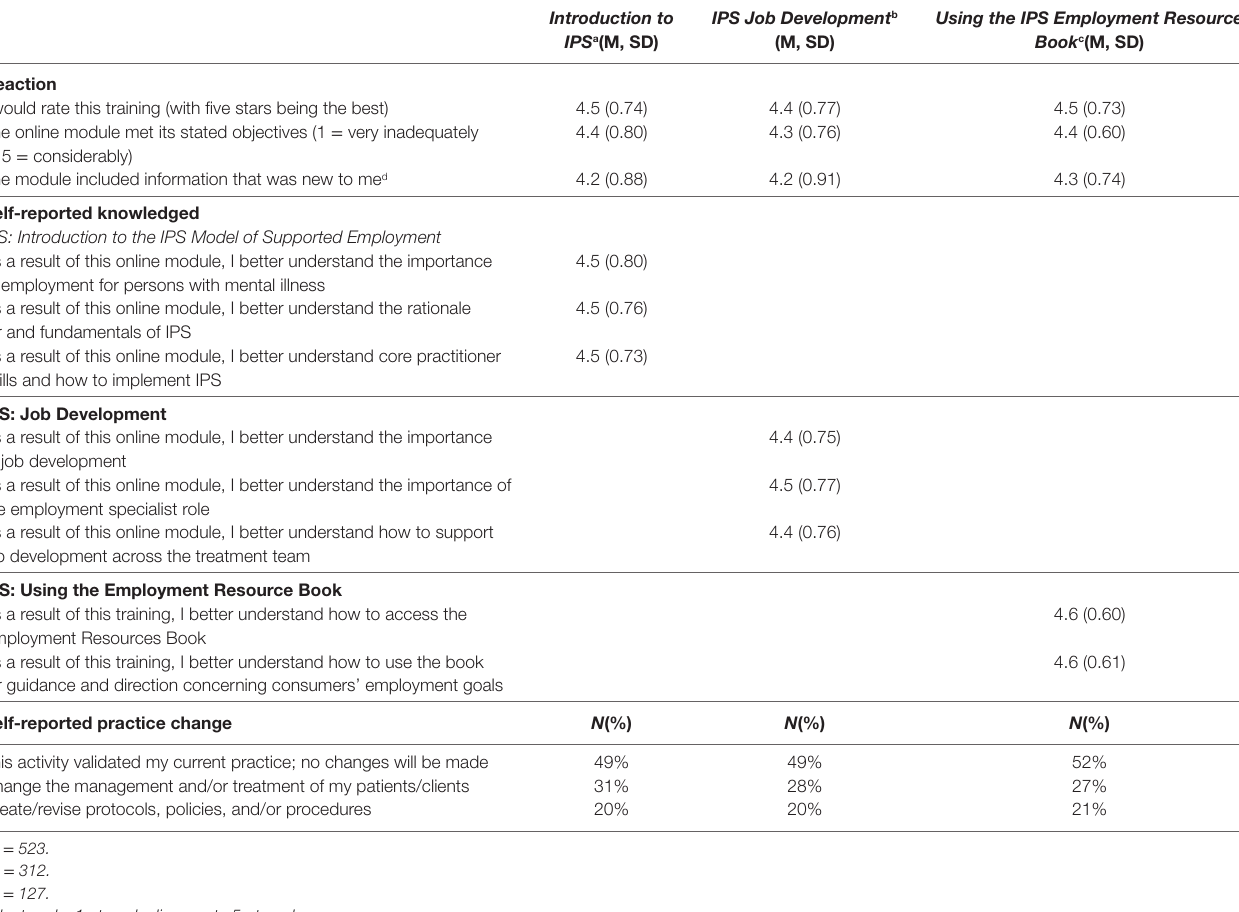
taBle 3 | Level 1 data from all three individual placement and support (IPS) modules.